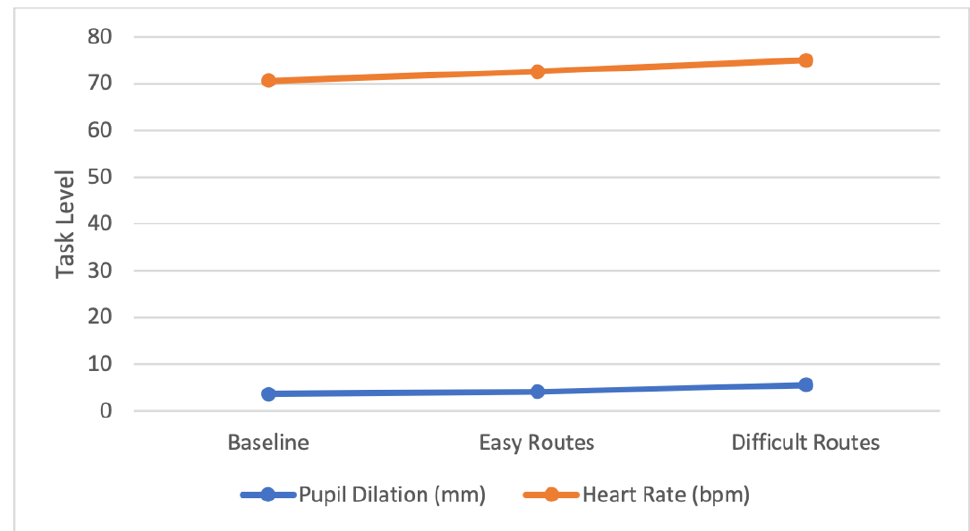
Figure 4. Mean physiological measures in relation to the task level.